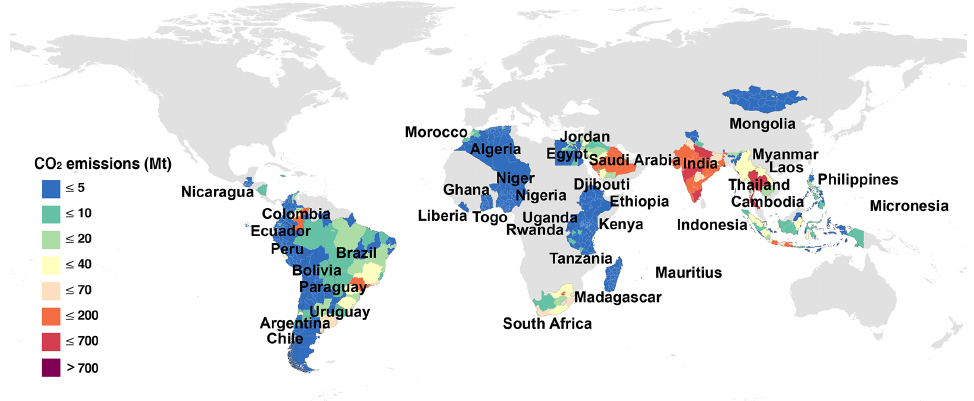
Figure 2. CO 2 emissions of the selected emerging economies in 2019 (in million tonnes). Darker blue indicates lower per capita emissions, and darker red indicates higher per capita